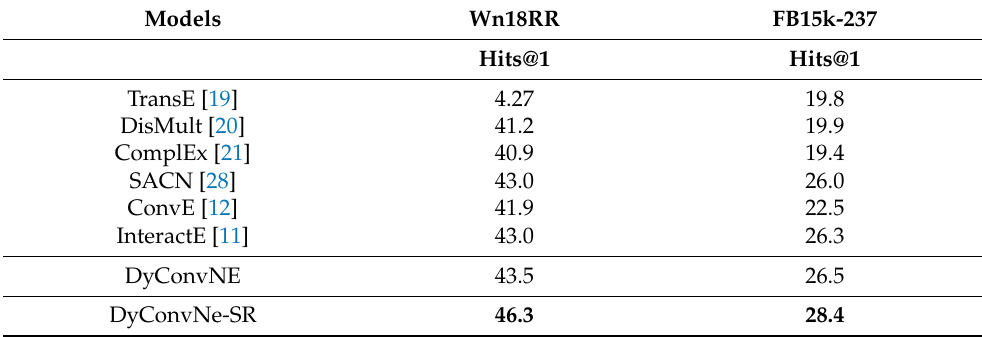
Table 7. The result of Hits@1 after using specific-relationship-testing on FB15K-237 and WN18RR. Hits@1 values are in percentage. The best score is in bold.